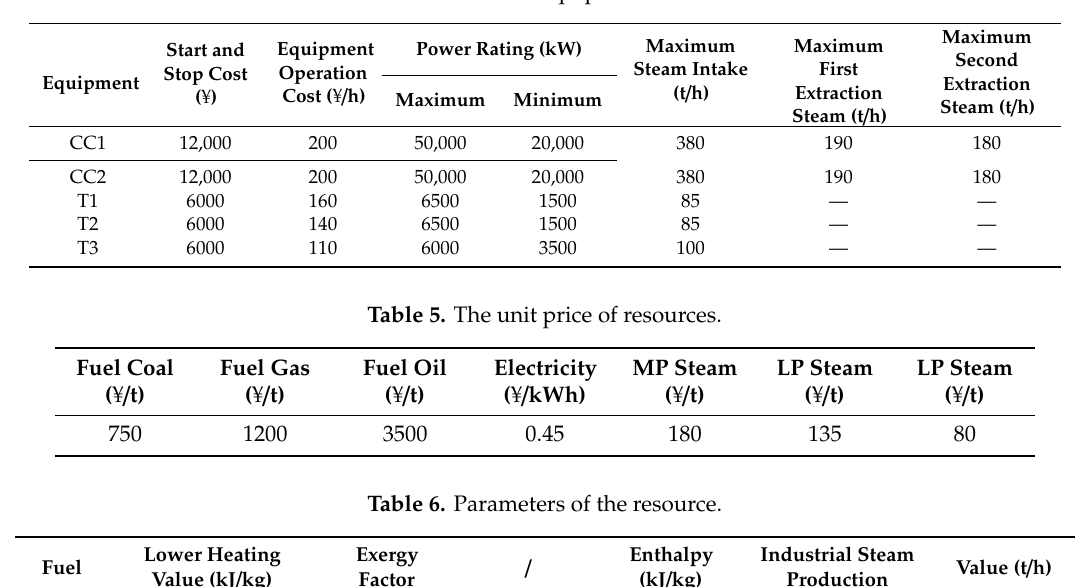
Table 4. Steam turbine equipment information.